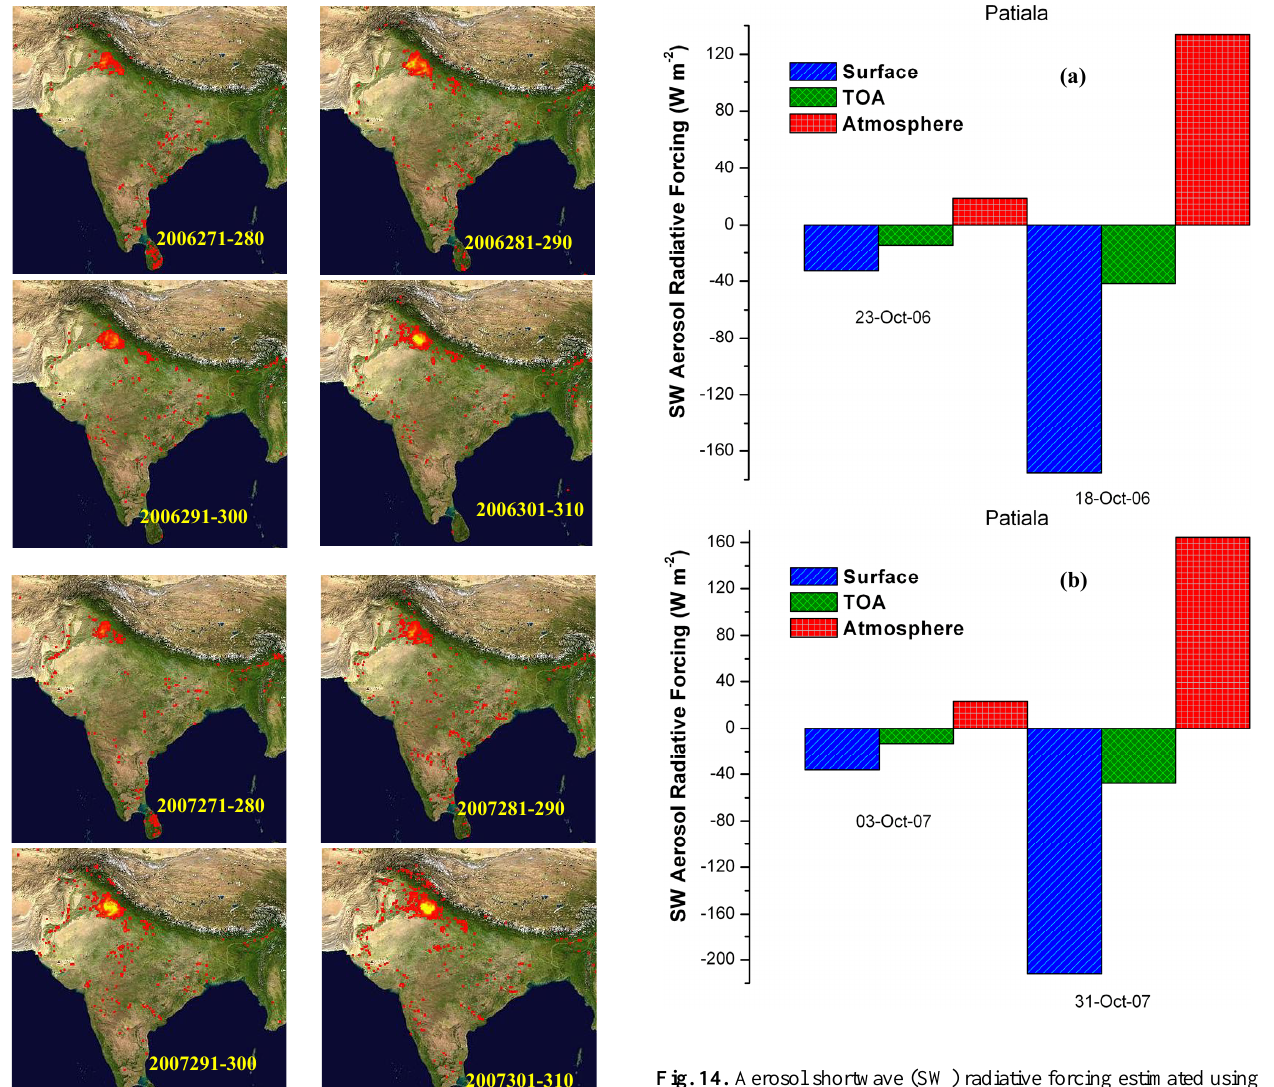
Fig. 14. Aerosol shortwave (SW) radiative forcing estimated using SBDART model over Patiala city during (a) 18 (turbid day) and 23 (clear day) October 2006 and (b) 3 (clear day) and 31 (turbid day) October